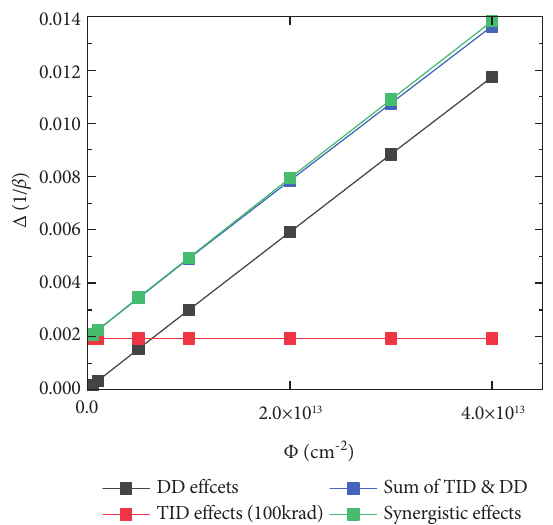
Figure 4: Synergistic effects of neutrons and 100krad gamma rays.